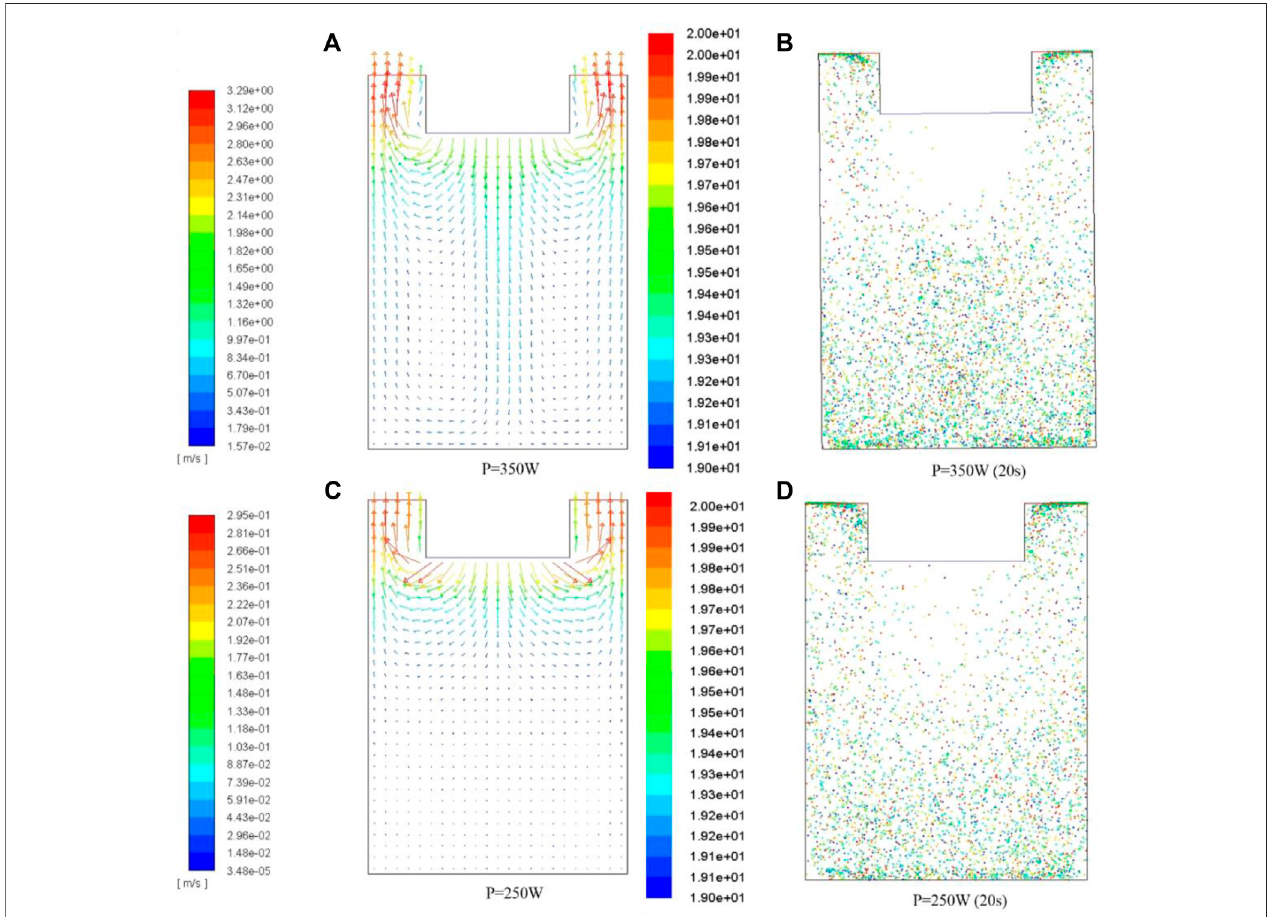
FIGURE 3 | Effect of different ultrasonic powers on particle distribution: (A,B) : 350 W and (C,D) : 250 W.